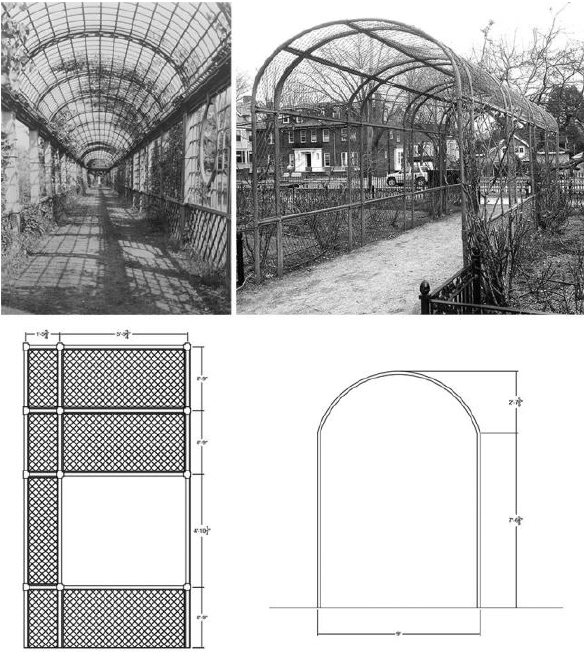
Figure 6. Trellis original and new location, and measurements Two fabrication techniques were used to create the main components of the model. For the site topography, the CAD contours were used to create laser-cut files. Once the final scale of the model was determined, each CAD contour was then laser-cut out of a piece of chipboard using a VLS 6.60 laser cutter. The model was separated into four quadrants so that the completed model could exceed the dimensions of the laser bed. Each layer was cut out and glued to the layer beneath, with building footprints cut into the model to allow the buildings to nest into the layer of chipboard. The buildings themselves were 3D printed out of plastic using a Zortrax M200 3D printer with ABS filament, with information being taken from archival drawings and